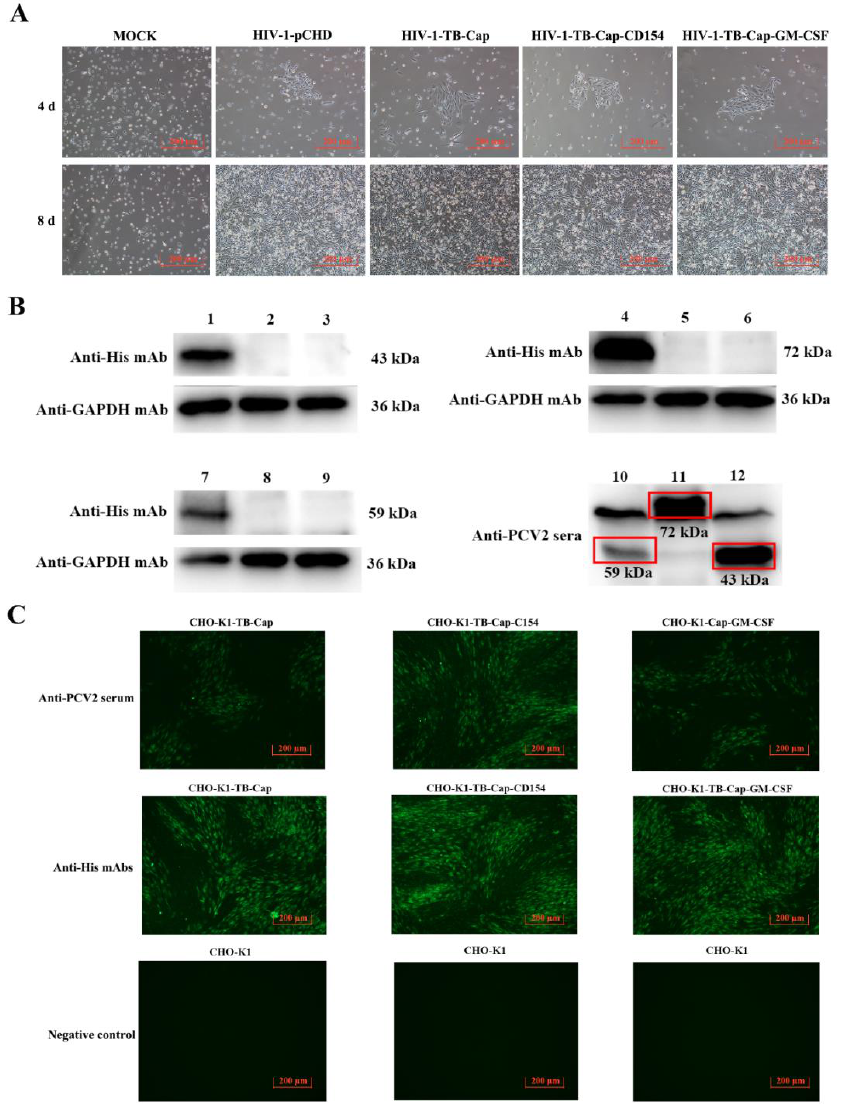
Figure 3. The recombinant CHO-K1 cells were screened with puromycin and the expression of recombinant TB-Cap, TB-Cap-CD154 and TB-Cap-GM-CSF proteins were analyzed by Western blotting and indirect immuno-fluorescence. ( A ) CHO-K1 cells were infected with different lentiviruses and screened by adding 14 µ g/mL puromycin. All cells not infected with the recombinant lentivirus died after 8 days; ( B ) the expression of recombinant TB-Cap, TB-Cap-CD154 and TB-Cap-GM- CSF were analyzed by Western blotting. Lanes 2,5,8: cell lysates of CHO-K1 cells (negative control); Lanes 3,6,9: cell lysates of CHO-K1-pCDH cells; Lane 1: cell lysates of CHO-K1-TB-Cap; Lane 4: cell